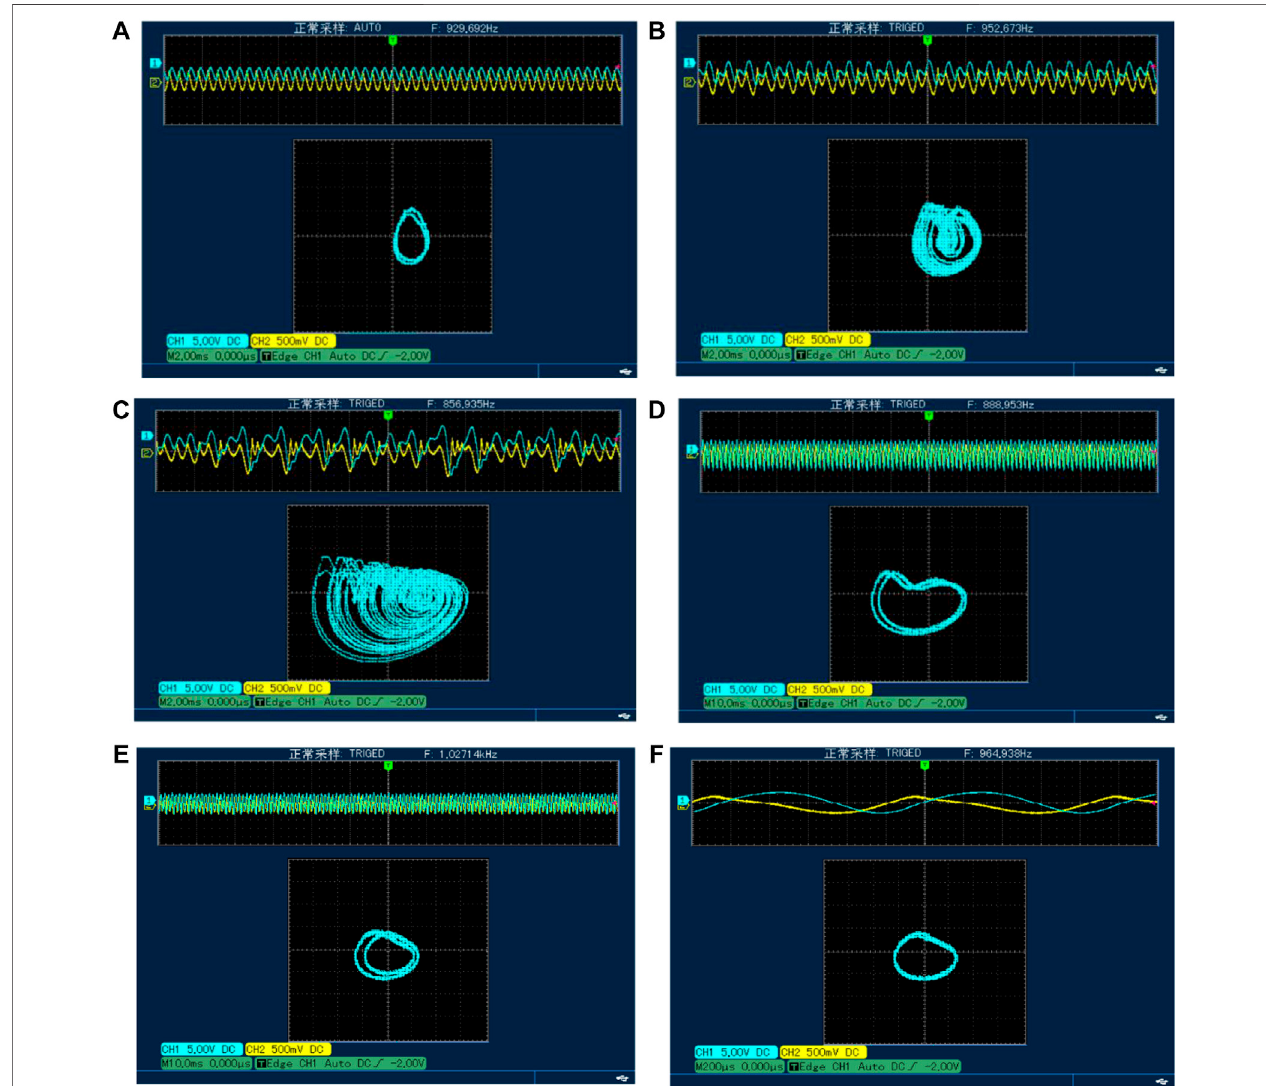
FIGURE 7 | Experiment results at different values of R1. (A) R1 = 34.48 k Ω . (B) R1 = 26.35 k Ω . (C) R1 = 19.8 k Ω . (D) R1 = 10.59 k Ω . (E) R1 = 8.32 k Ω . (F) R1 = 7.67 k Ω .